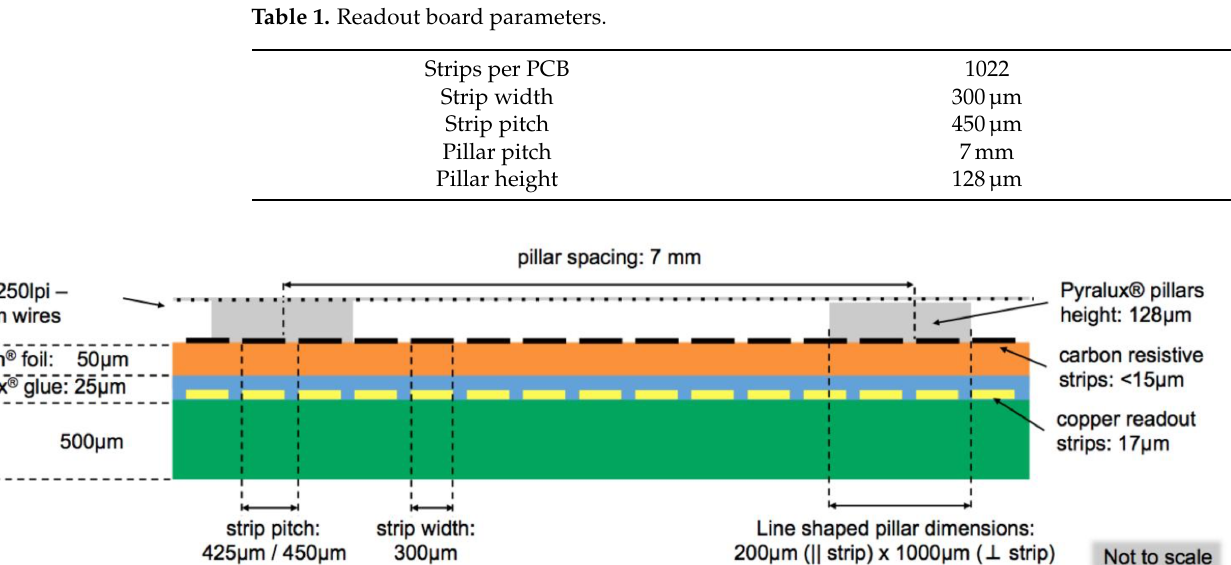
Figure 12. Structure of the RO